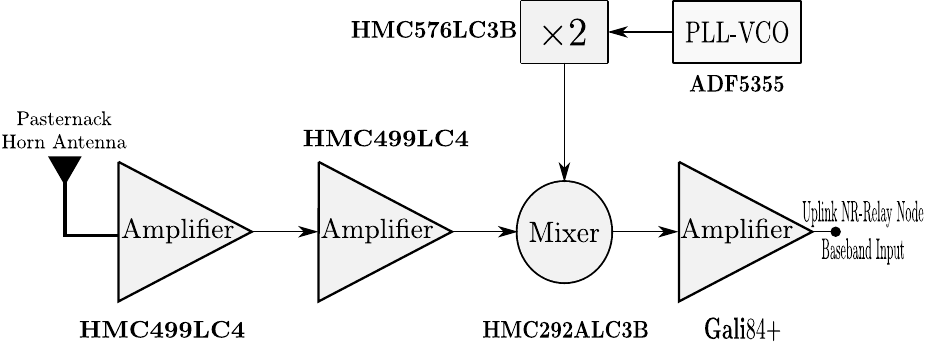
Figure 10. Implementation architecture of the mmWave receiver chain